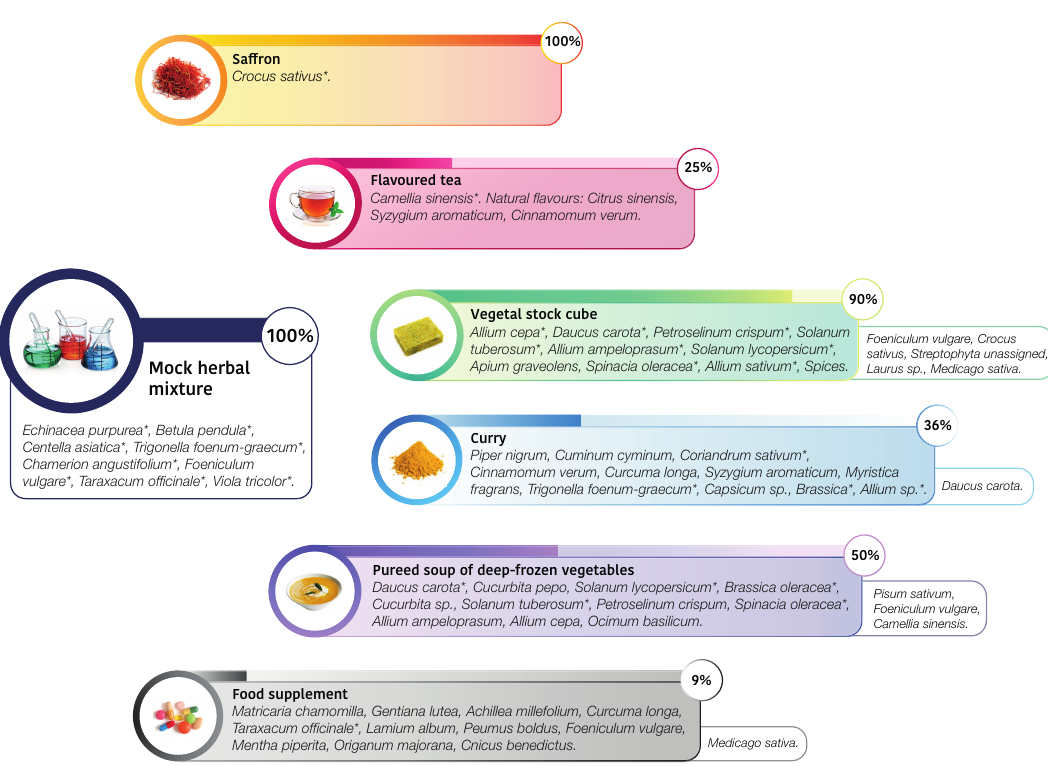
Figure 1. Schematic overview of commercial processed foods and mock herbal mixture tested with DNA metabarcoding approach. The percentage bars report the “observed/expected” percentage, that is the match in what was declared in the ingredients label and what we detected using DNA metabarcoding; not declared specimen/contaminants are excluded from the percentage calculation and listed in the boxes on the right. See also Table 1.